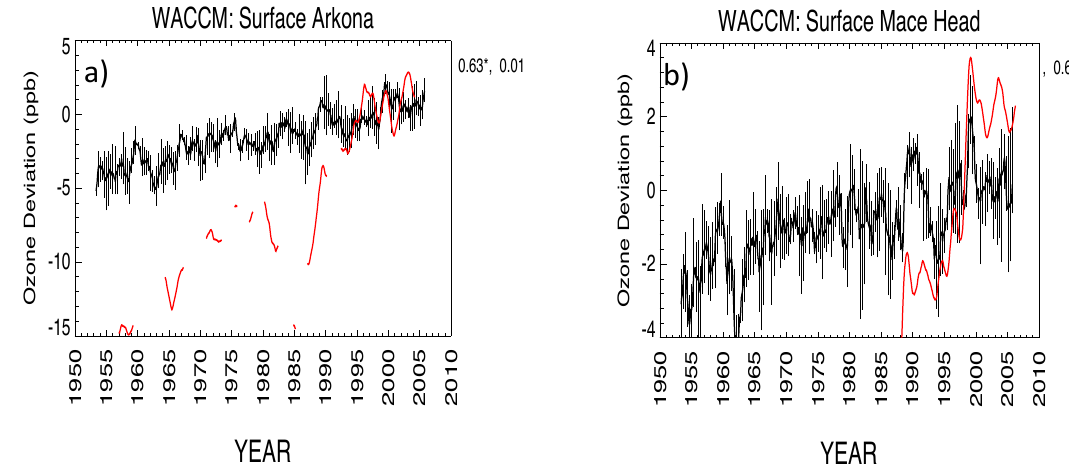
Figure 6. As in Fig. 3 but for (a) the surface measurements at Arkona and (b) the surface measurements at Mace Head.